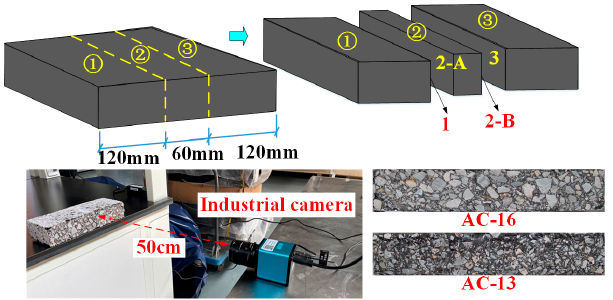
Figure 3. Specimen section image acquisition process.